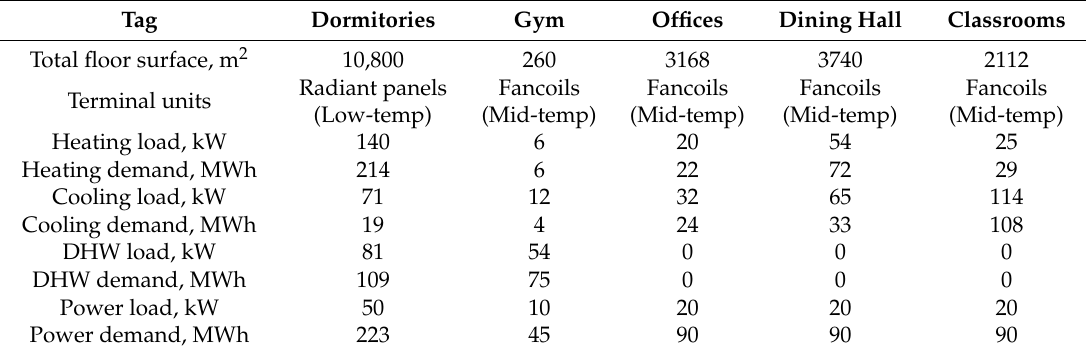
Table 1. Peak values and energy needs for the four services of the campus and for the five types of buildings.